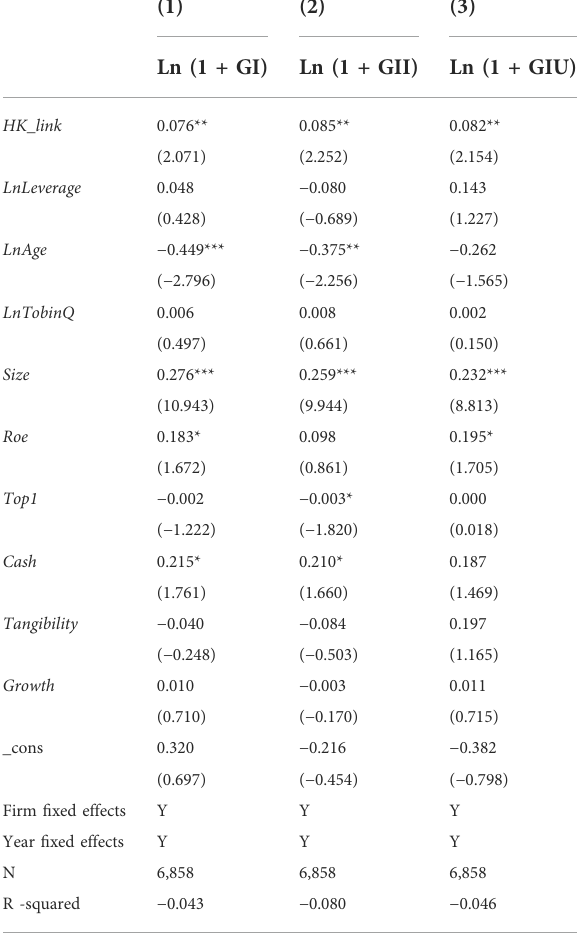
TABLE 8 Robustness test: Fixed effect